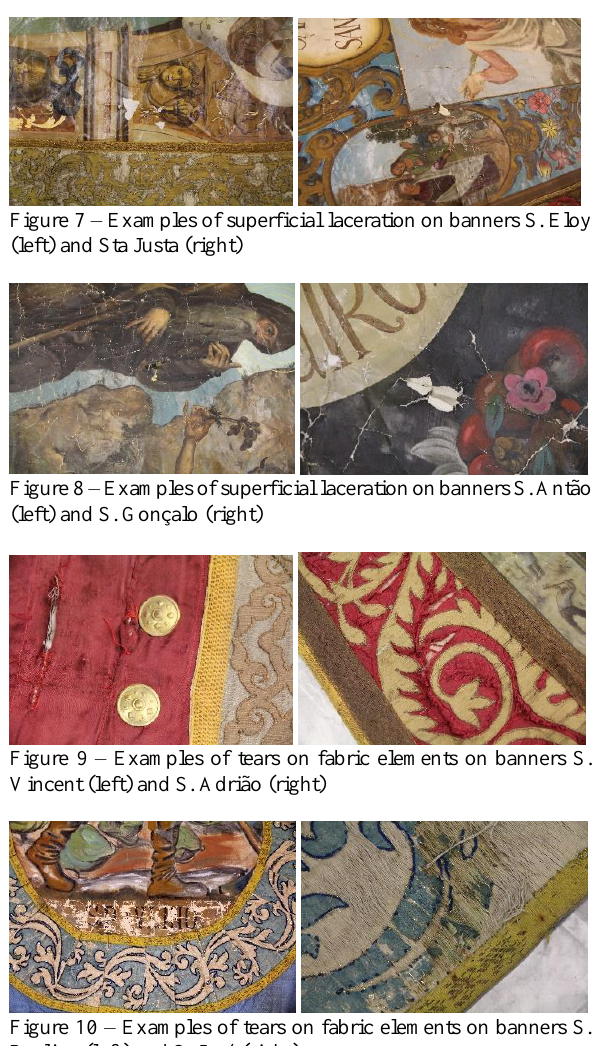
Figure 12 – Back of the banner (left) and banner with textile strip extensions on there sides (right)